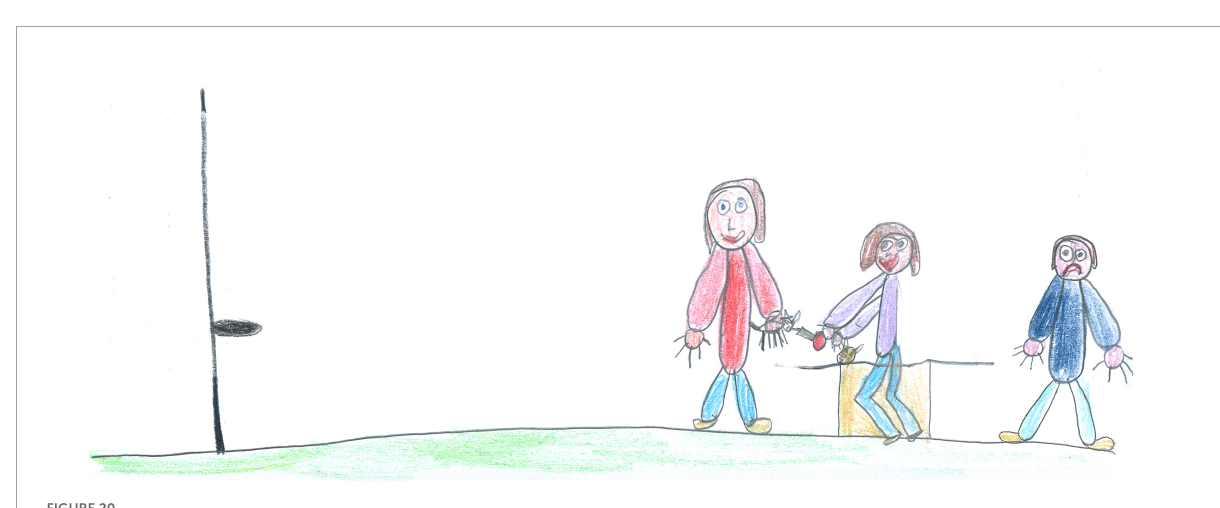
FIGURE20 An example of PAIR’s opposite emotions (PS, Male, 8